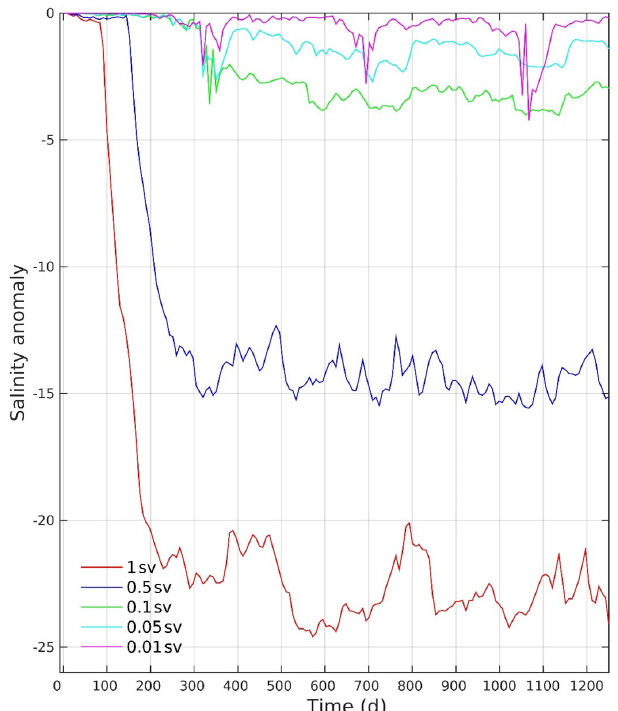
Figure 3. Simulated salinity anomalies over time at Site U1357 for the five meltwater release